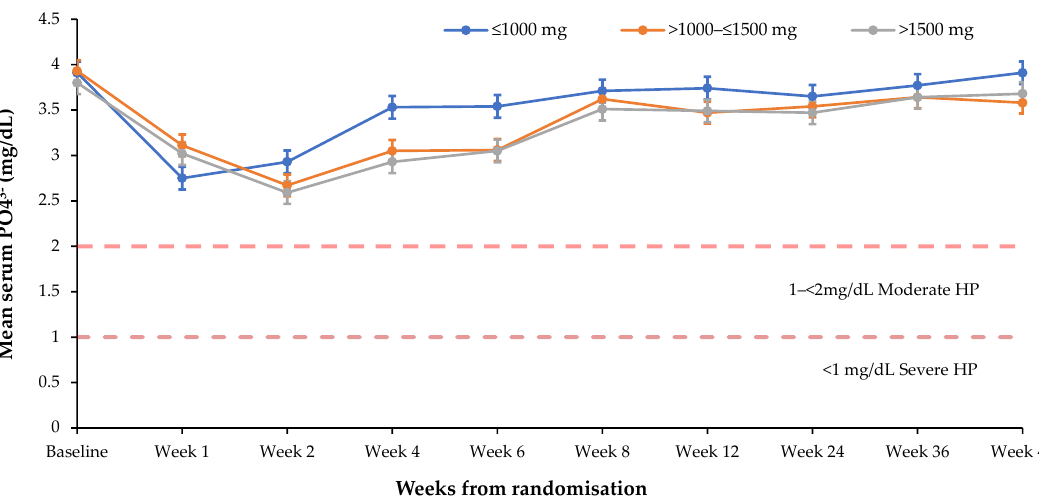
Figure 4. Mean serum PO 43 − levels over time by cumulative ferric carboxymaltose dose. Cumulative FCM dose ≤ 1000 mg ( n = 3131), > 1000– ≤ 1500 mg ( n = 2602), > 1500 mg ( n = 1146). Bars denote standard error of the mean. The drop in serum PO 43 − was greater in subjects receiving a cumulative FCM dose > 1000– ≤ 1500 mg vs. ≤ 1000 mg. FCM, ferric carboxymaltose; HP, hypophosphataemia; PO 43 − ,